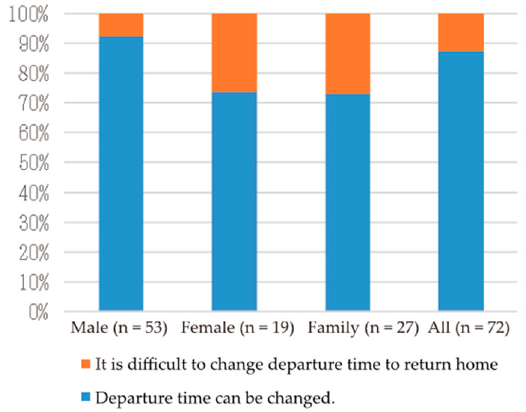
Figure 5. Intention to change departure time for returning home.